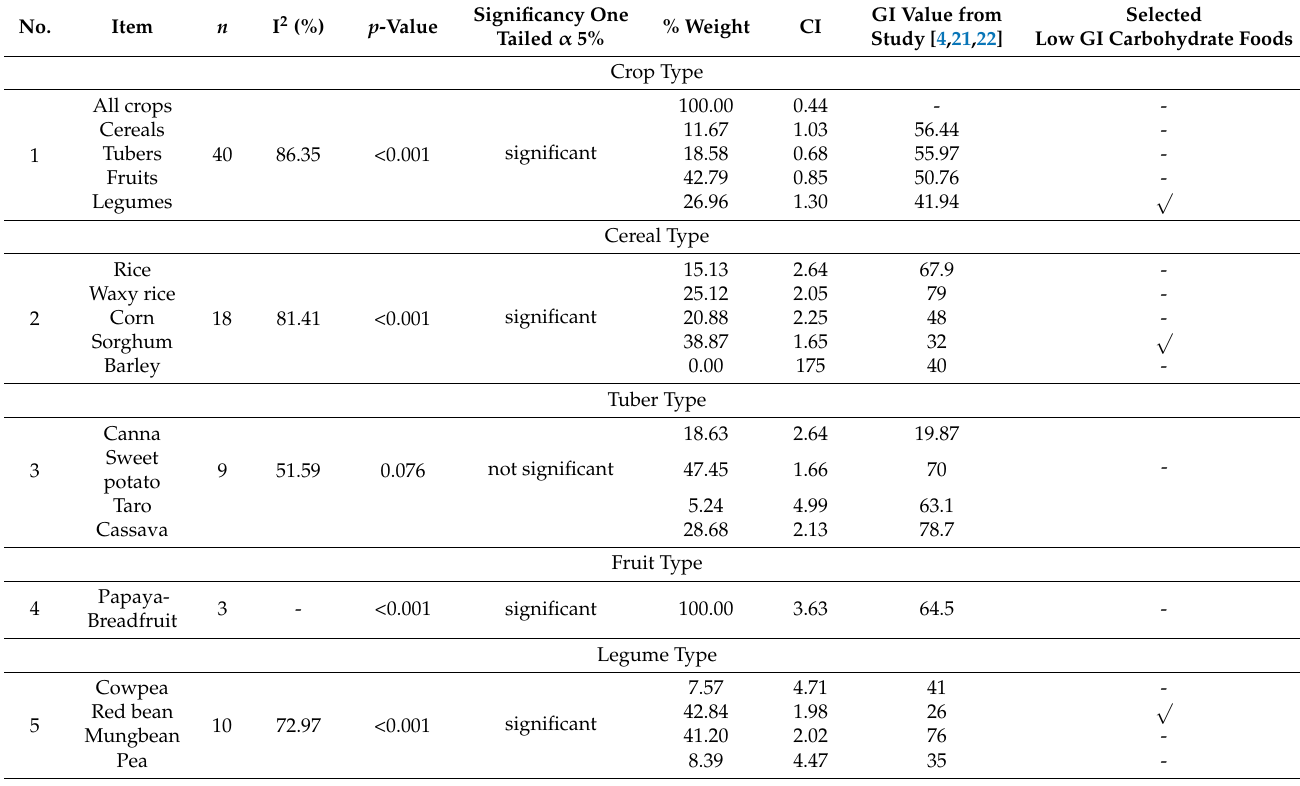
Table 5. Selected low-GI carbohydrate foods using meta-analysis in in vitro studies.